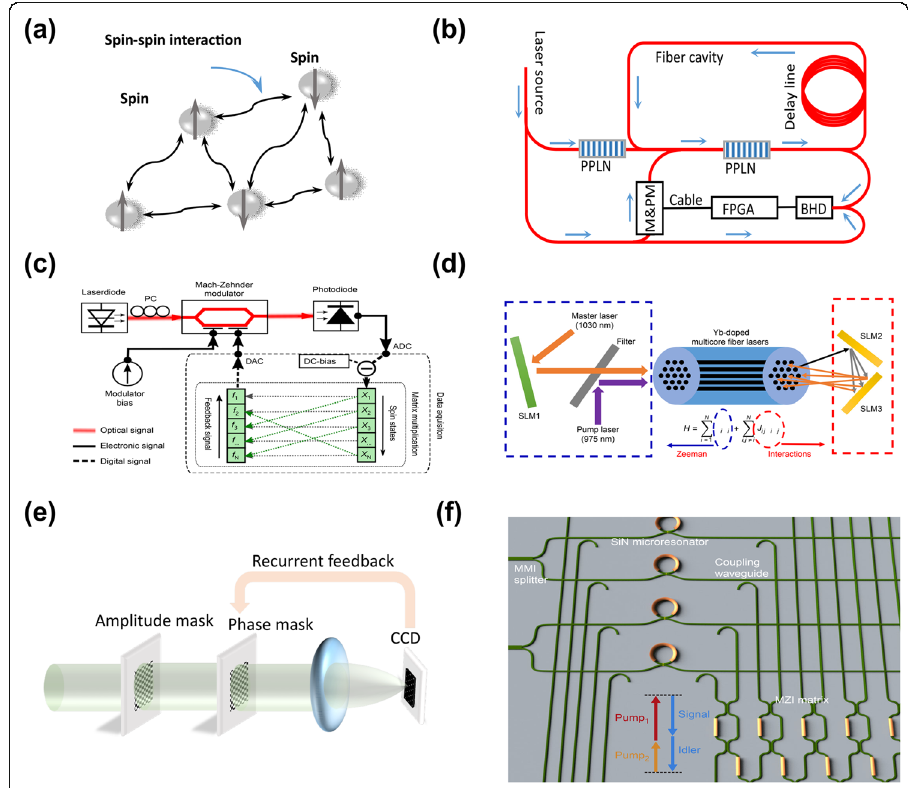
Fig. 5 Overview of optical Ising machine. a Ising model. b Schematic of coherent Ising Machine (CIM) based on degenerate OPO. c Ising machine works in nonlinear regime of modulator [143]. d Ising machine based on multi-fiber. e Simulated annealing based on SLM. f Schematic of all-optical Ising machine [151]. Figures adapted under a CC BY 4.0 licence from ref. [143] (c) , ref. [144] (d) , ref. [151]